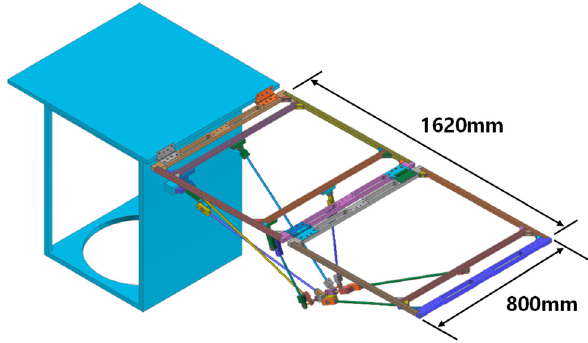
Figure 3. Configuration of a deployment analysis model. Table 4. Length and weight of truss-link mechanism.